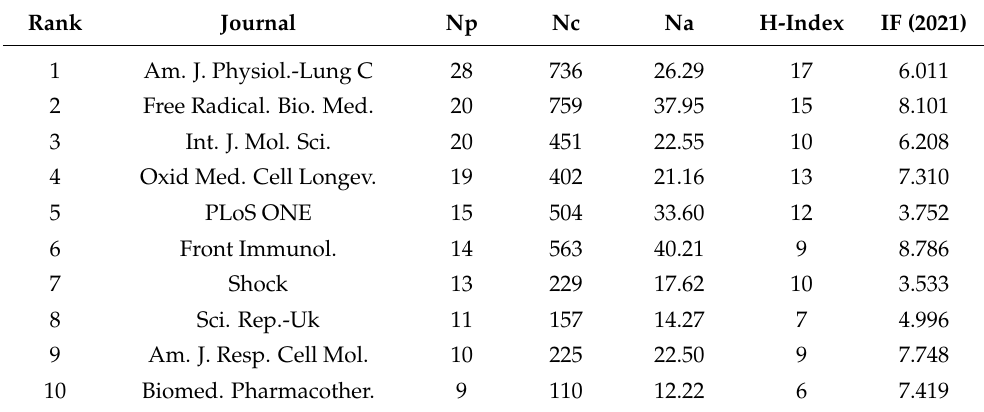
Table 3. The top 10 productive